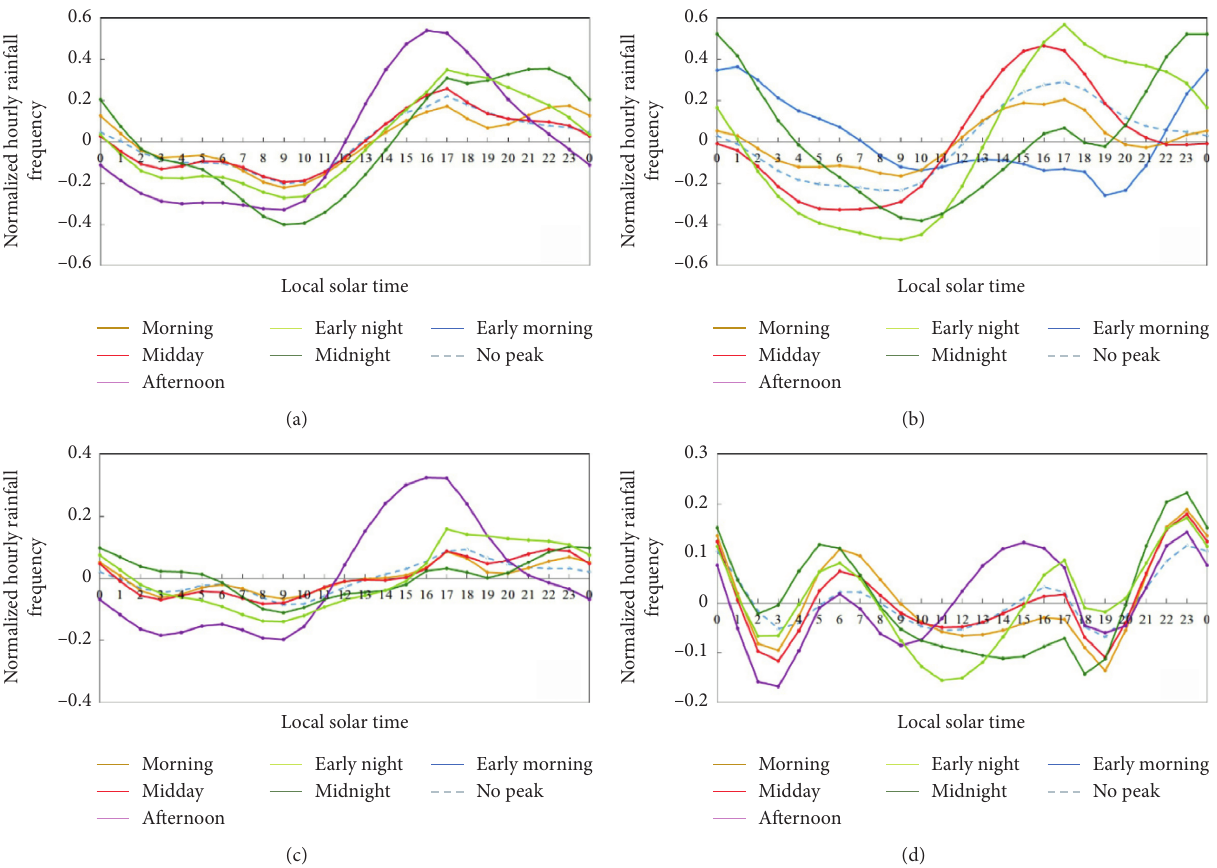
Figure 6: Curves of normalized hourly TRMM precipitation frequency, calculated based on the classification of diurnal variation of precipitation in Figure 2: (a) for spring, (b) for summer, (c) for autumn, and (d) for